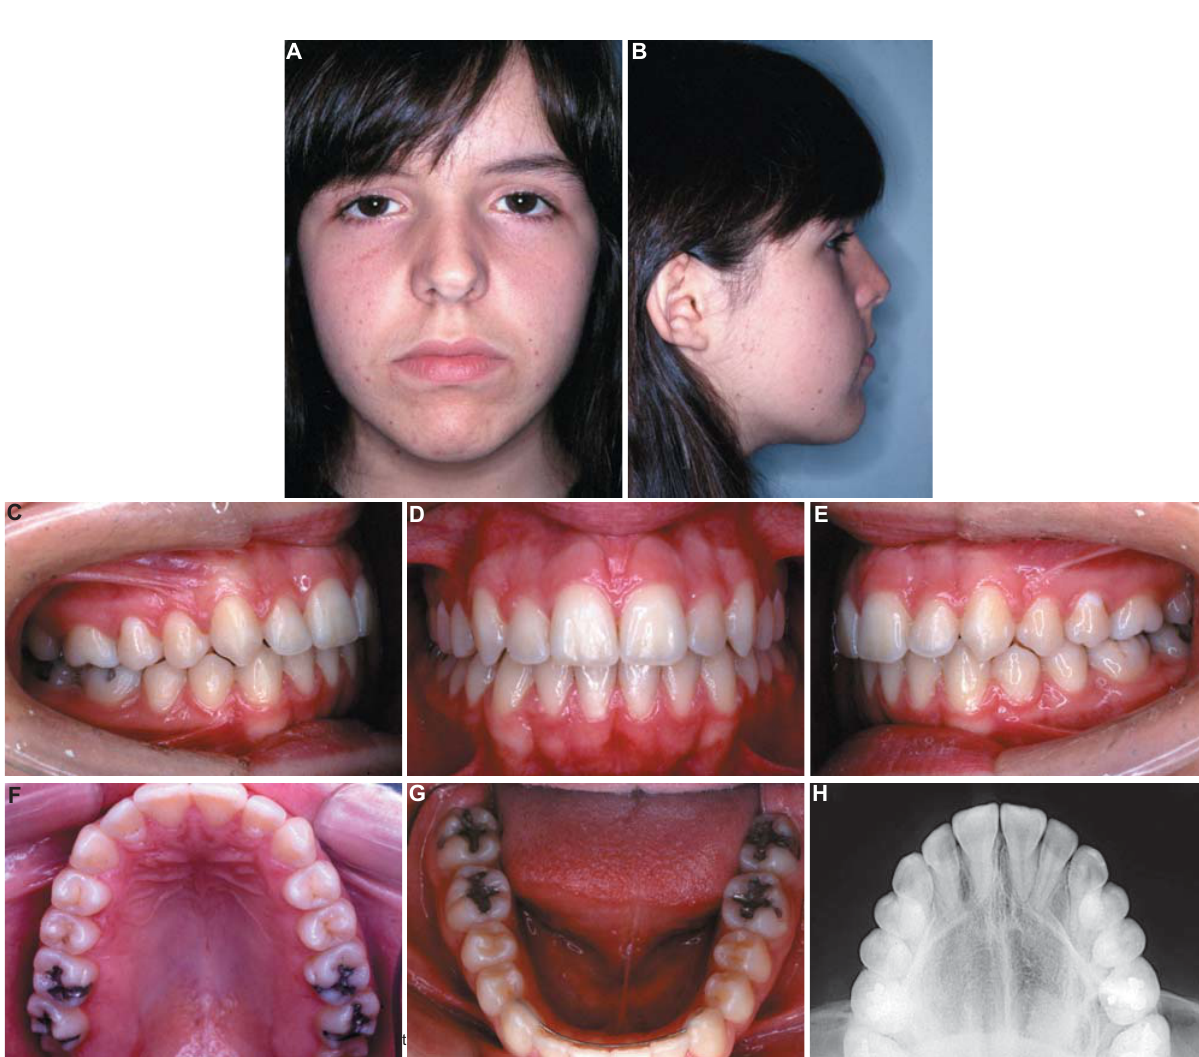
Figure 4- Intraoral (A-D) and radiographic (E) aspects of the corrective phase Figure 5- Extraoral (A and B) and intraoral (C-G) photographs at the completion of treatment. Radiographic aspect